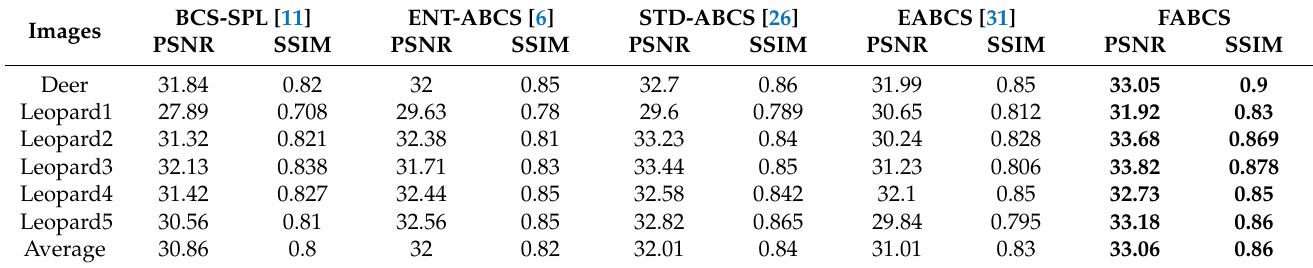
Table 3. Performance comparison of the state of the art methods at 0.5 SR on CCTV images.